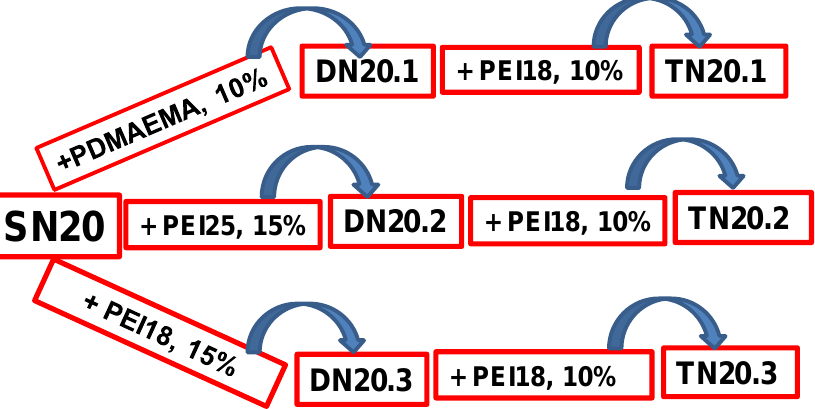
Figure 1. Synthesis strategy of DN and TN composite cryogels starting from the single network of CS cross-linked with 20 mole% GA.